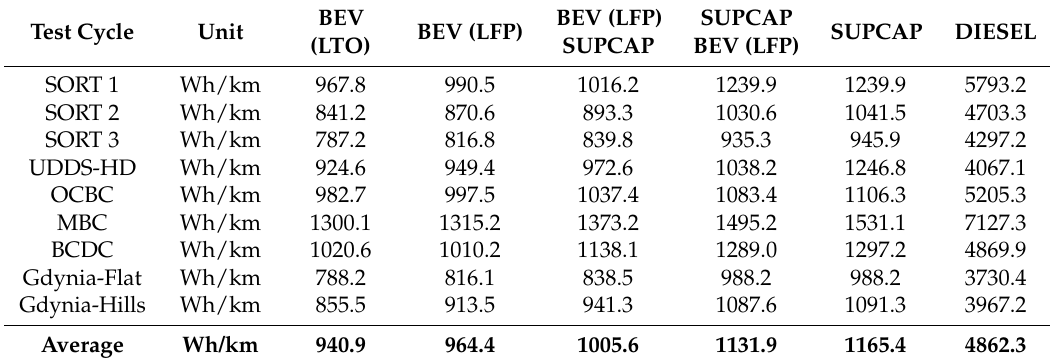
Table 2. Average energy consumption for a given test cycle and configuration of electric drive system.